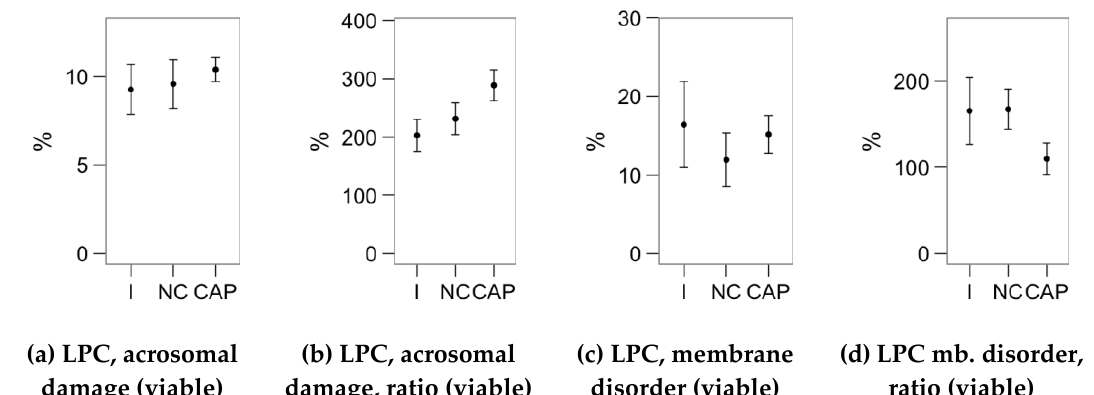
Figure 3. Results of sperm analyses (calcium levels and ionophore and lysophosphatidylcholine–LPC challenges; flow cytometry) in the unprocessed samples (initial assessment, I) and after the incubation (4 h at 37 °C and 5% CO 2 ) in non-capacitating (NCAP) and capacitating (CAP, 2 UI/mL heparin) conditions. Plots show mean s ± SEM. ( a ) Spermatozoa with damaged acrosome as the ratio of viable spermatozoa. ( b ) Capacitated spermatozoa as with increased membrane disorder (M540 + ), as the ratio of viable spermatozoa. ( c , d ) Same parameters as the ratio of measurements after and before the ionophore treatment (ratio of change). No significant differences of the incubated samples with the initial assessment were detected.